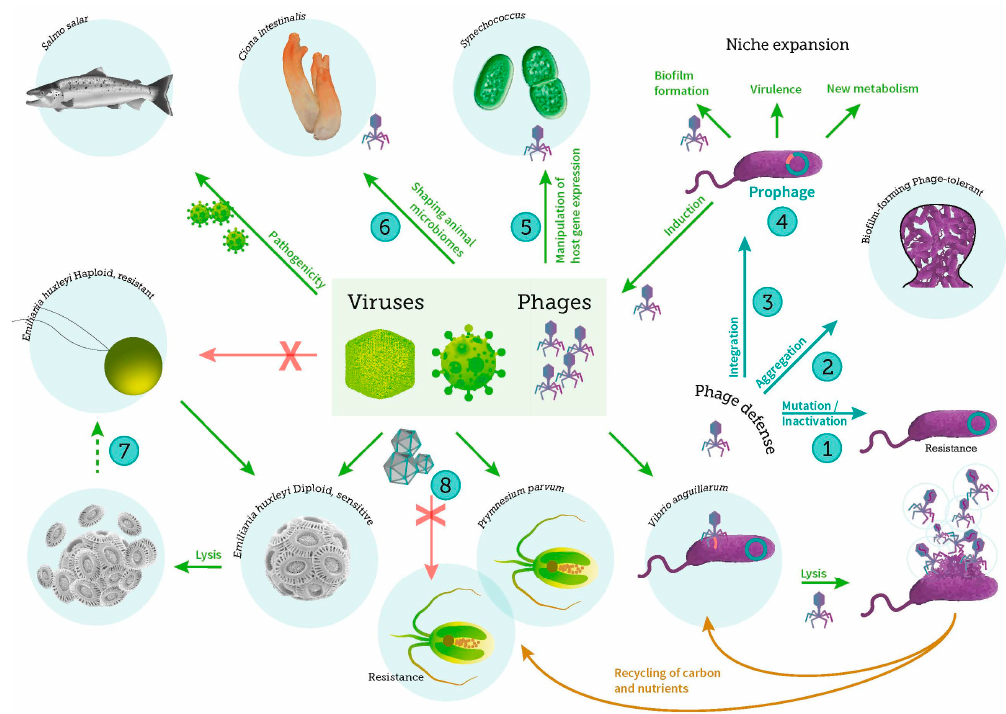
Figure 1. Schematic overview of important virus-host interactions in the marine ecosystem covered in this special issue, including viral infection of bacteria, phytoplankton, and fish. Specific explanations of key interactions: (1) Bacteria can prevent phage infection by mutational modification of surface receptors or by enzymatic degradation of the incoming phage DNA; (2) Alternatively, protection of cells in aggregates or biofilms can be a defense strategy against phage infection; (3) Infection by temperate phages can result in the integration of the phage DNA in the host genome as prophage; The integrated prophage can prevent infection by similar phages (Superinfection exclusion mechanism) and (4) contribute with important genetic information to the host that may expand its metabolic or virulence properties. Prophage induction leads to the release of new phages and may also stimulate biofilm formation; (5) Phages can manipulate host gene expression in cyanobacteria for improved infection efficiency, either by exploiting the host genes or by encoding host photosynthesis genes which are then expressed during infection; (6) Phage interaction with their bacterial hosts contributes to shaping the gut microbiome of invertebrates (e.g., tunicates), thus affecting the symbiotic relationship between gut microbes and their hosts; (7) In the coccolithophorid phytoplankton Emiliania huxleyi the diploid virally infected cells may undergo viral induced lysis or re-emerge (dotted arrow) as haploid cells containing viral RNA and lipids. These haploid cells are thought to resist virus infection (as indicated with the X) and develop into the diploid cells by karyogamy; (8) The large and diverse group of nucleocytoplasmic large DNA viruses (NCLDV) infects a range of photosynthetic protists such as the prasinophytes Micromonas pusilla and Ostreococcus tauri and, as exemplified in the figure, the toxin-producing haptophyte Prymnesium parvum , thus affecting mortality, diversity and production of phytoplankton. These interactions are strongly controlled by environmental factors such as temperature, nutrient availability and light. As for bacteria, several mechanisms of resistance (indicated with an X) to viruses have been described in the photosynthetic protists (see text for further